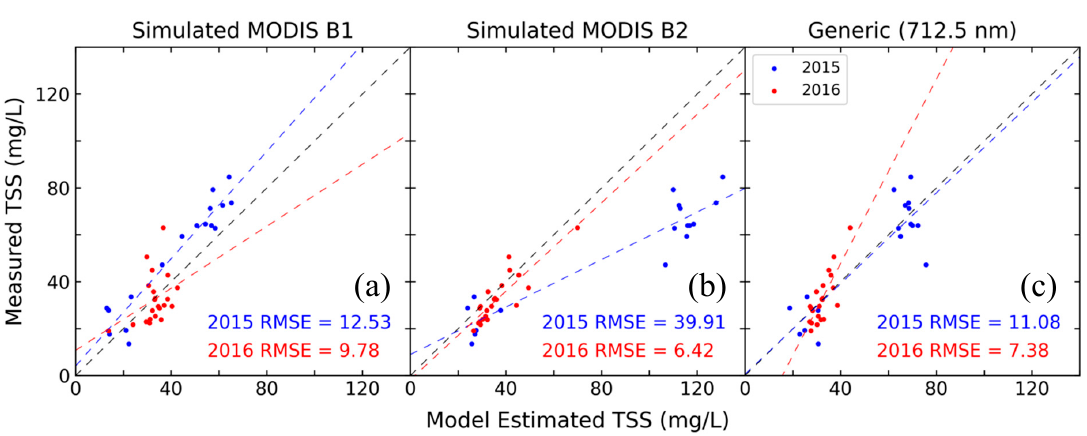
Table 3 . Validation data and results for the derivative ‐ based PLSR algorithm.